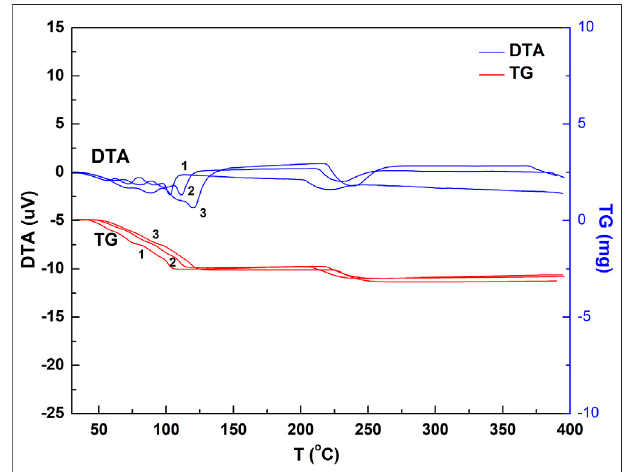
FIGURE 3 | DTA and TG spectrogram of the chalcanthite crystals at different heating rates. Note: upper curves 1, 2, and 3 are DTA pro fi les of the chalcanthite crystalsat heating rates of3, 5, and 10 ° C/min, respectively, while lowercurves1,2,and3areTGpro fi lesofchalcanthitecrystalsatheating rates of 3, 5, and 10 ° C/min,